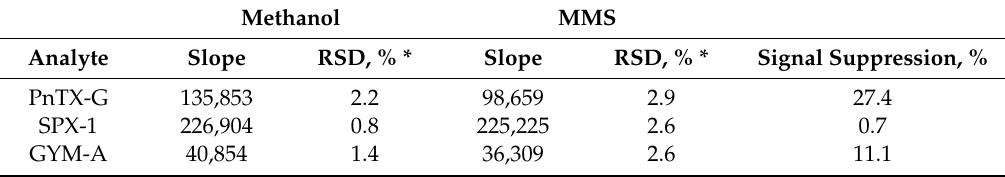
Table 2. Mean slope and relative standard deviation (RSD) for a nine-point calibration curve for CIs using methanol and matrix-matched standards (MMSs); calibration curve data is the mean of three sets of calibration ranging from 0.1 to 40 ng / mL.